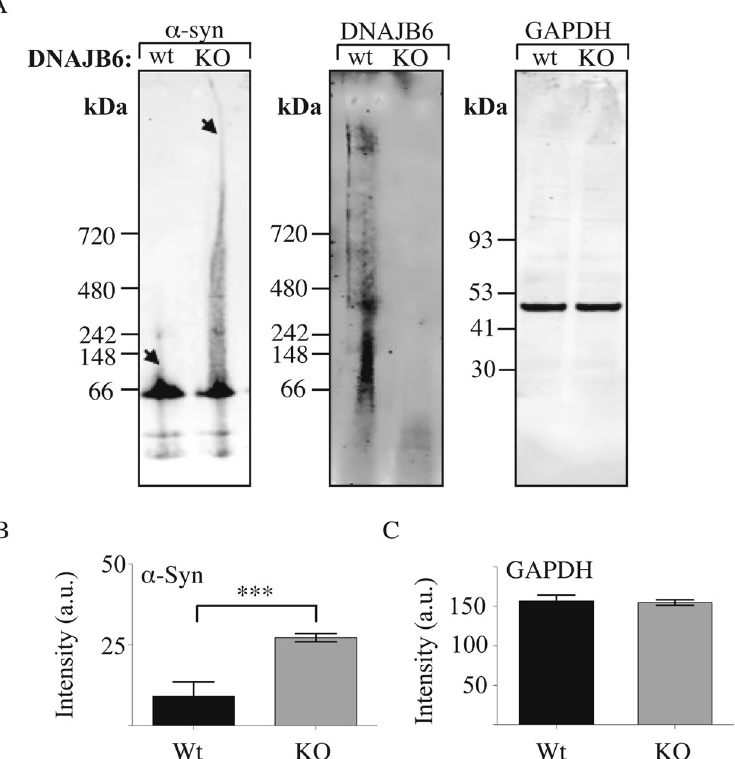
Figure 3. Western blots of native PAGE on soluble proteins in WT and DNAJB6 KO cells. ( A ) From left to right, representative western blots probed against α -synuclein and DNAJB6. As loading control, same samples were also analysed by SDS-PAGE and probed against the protein GADPH. ( B ) Densitometry analysis of the western blots probed against α -synuclein (n = 5) and ( C ) Densitometry analysis of the western blots probed against GADPH (n = 5). Statistical analysis was performed by one-way ANOVA. *** P <